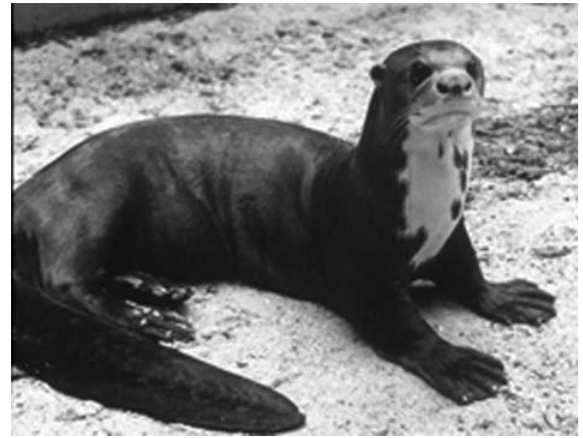
Figure1 -Amazoniangiantotter( Pteronurabrasiliensis )heldincaptivity at the Aquatic Mammals Laboratory of the Brazilian National Institute for Amazonian Research (Instituto Nacional de Pesquisas da Amazônia, INPA), Manaus, Amazonas (AM), Brazil.